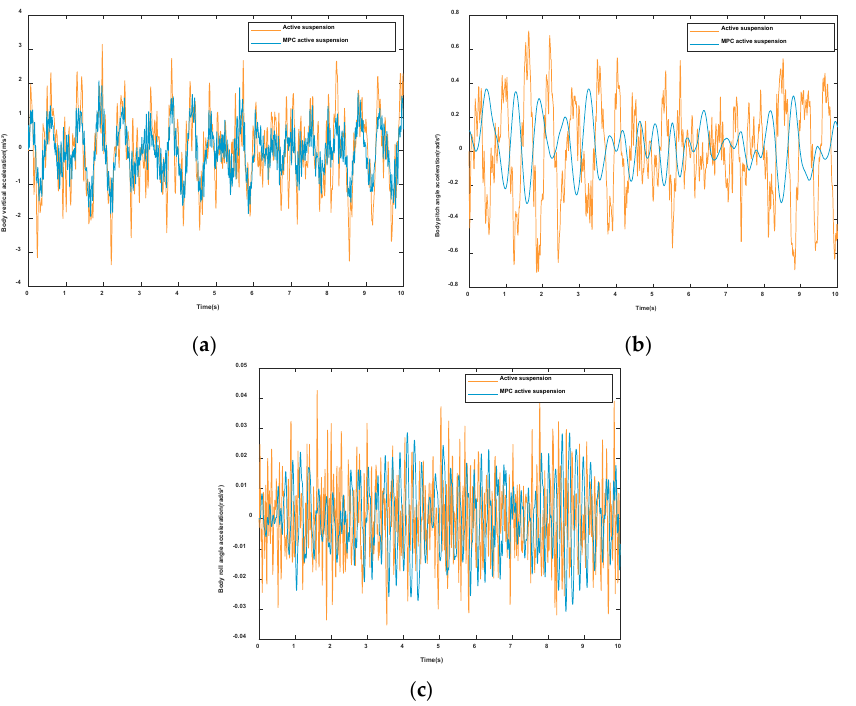
Figure 7. Vehicles under turning conditions: ( a ) Suspension actuation force . ( b ) Vertical acceleration . ( c ) Pitch angular acceleration . ( d ) Roll angular acceleration. In this paper, the proposed control strategy is compared to the conventional model stability of the vehicle. The simulation results are shown in Figure 8. It can be seen intui- tively from the figure that the vertical acceleration (Figure 8a) and the pitch angular ac- celeration (Figure 8b) of the vehicle body are greatly reduced, and the roll angular accel- eration (Figure 8c) has also been improved. It can be seen that the control strategy has achieved good effects on ride comfort and driving stability.